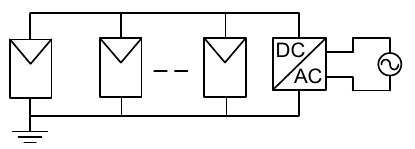
Figure 13. Illustration of the PV-wire-free system concept.